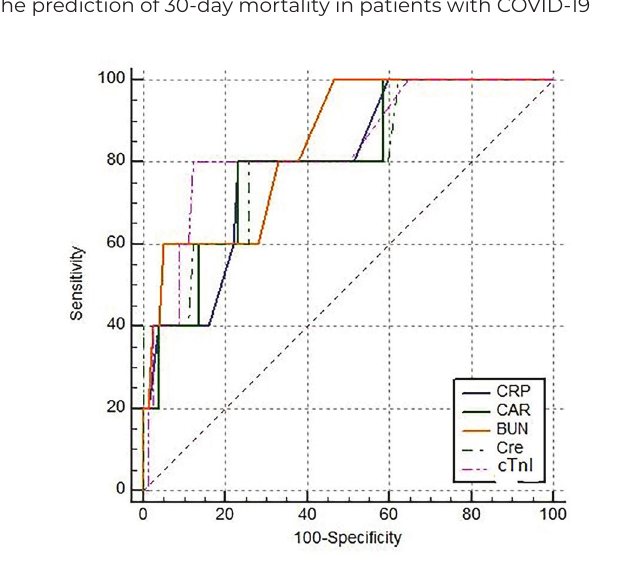
ED: emergency department; AUC: area under the curve; PPV: positive predictive value; NPV: negative predictive value; LR: likelihood ratio; CI: confidence interval; cTnI: high-sensitive cardiac troponin I, BUN: blood urea nitrogen; CRP: C-reactive protein; CAR: C-reactive protein-to-albumin ratio Figure 1 - Receiver operating characteristic curves for C-reactive protein (CRP), C-reactive protein-to-albumin ratio (CAR), blood urea nitrogen (BUN), creatinine (Cre) and Troponin I (Trop) for the prediction of 30-day mortality in patients with